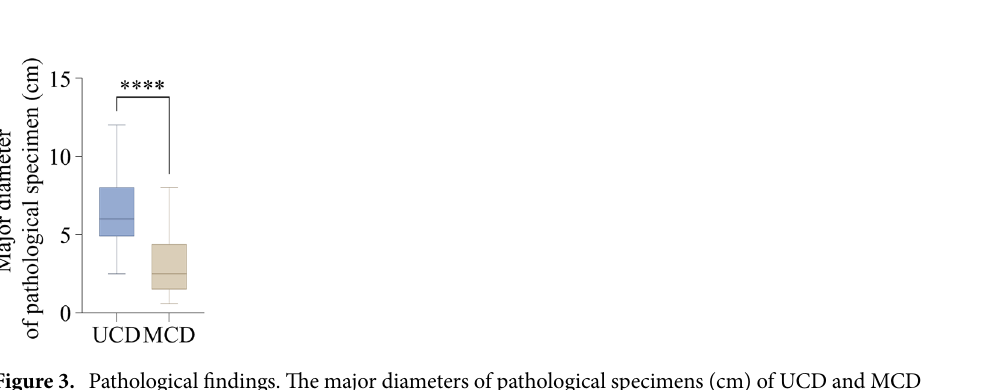
Figure 2. Clinical findings. ( a ) Locations of lymphadenopathy of 33 UCD patients; ( b ) Locations of lymphadenopathy of 32 MCD patients; ( c ) Locations of lymphadenopathy of total 65 patients; ( d ) Comorbidities in 65 patients with CD in this study.